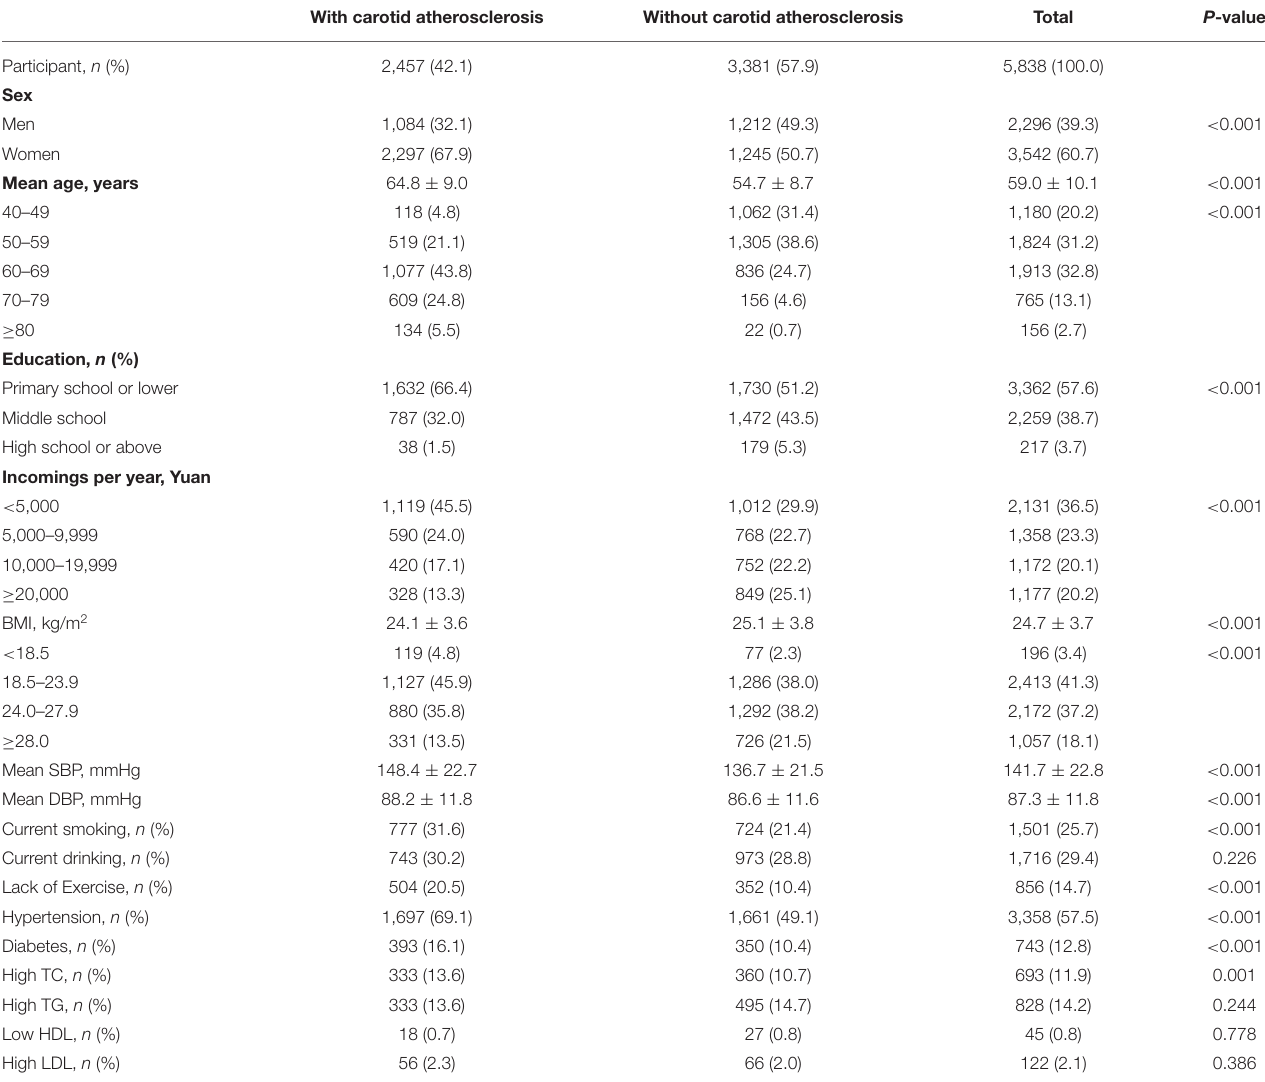
TABLE 1 | Characteristics of the study participants. With carotid atherosclerosis Without carotid